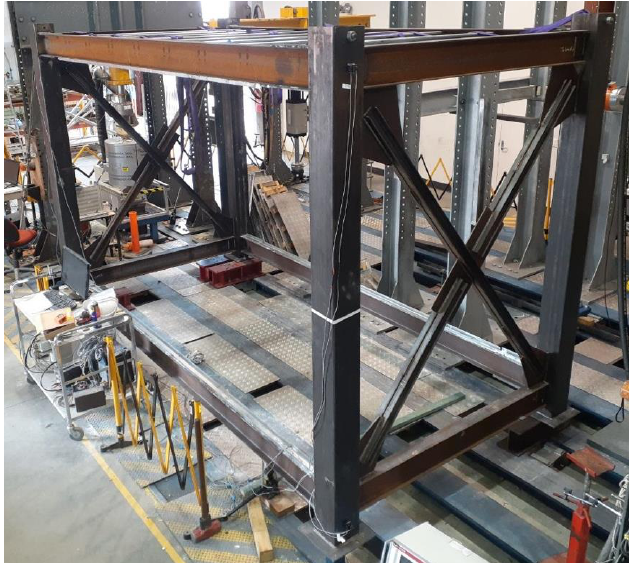
Figure 2. Fabricated module fixed to the strong floor.